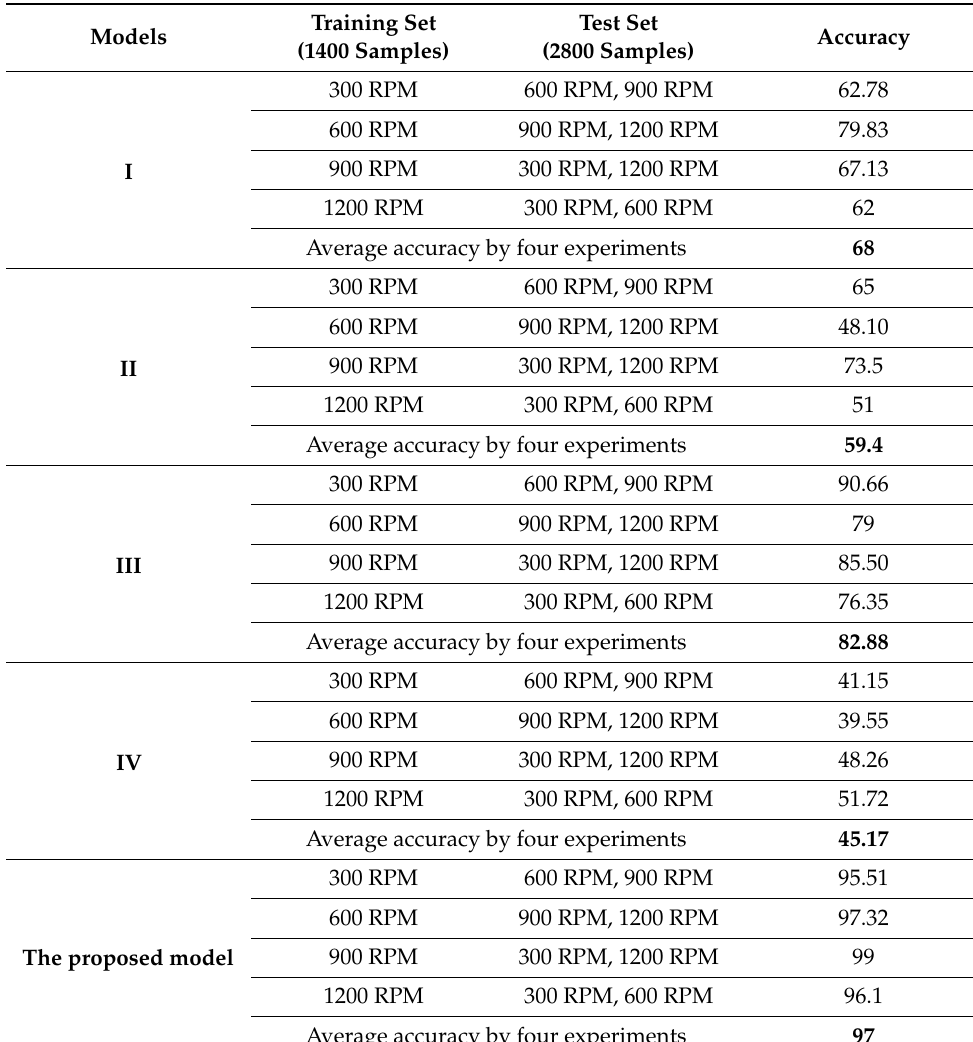
Table 5. Classification results of the referenced and proposed models in four experiments based on various rotating speed